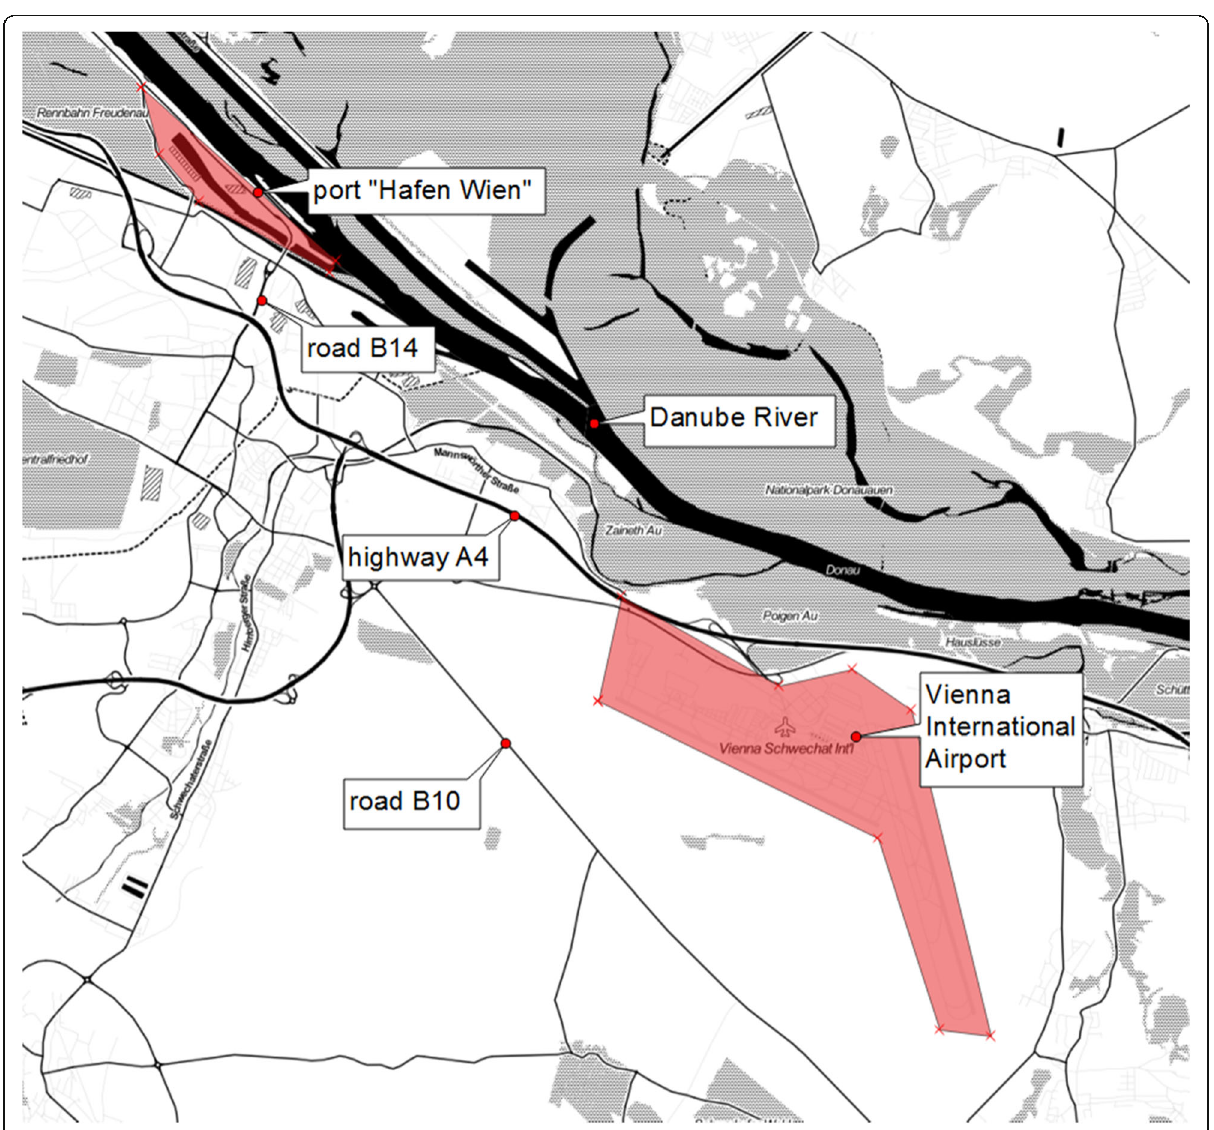
Fig. 1 Existing transport connection between port of Vienna and Vienna International Airport